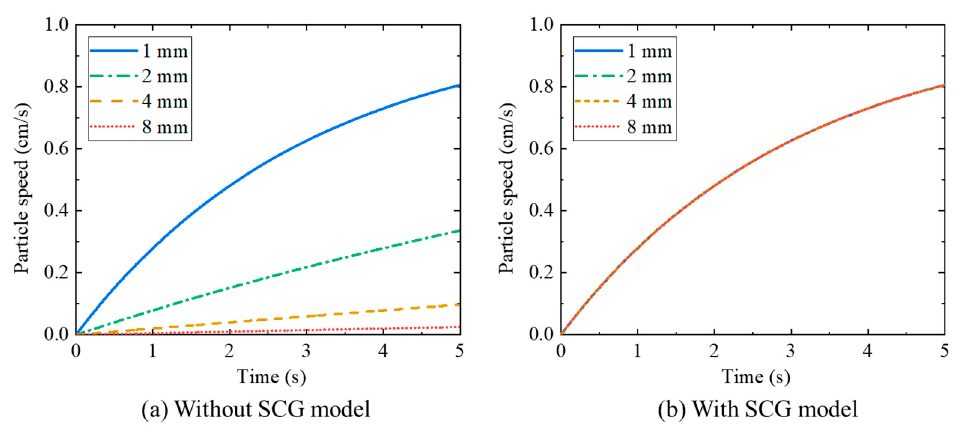
Figure 3. Comparison of the particle speeds on uniform flow field represented by DEM with and without the coarse-grain model.